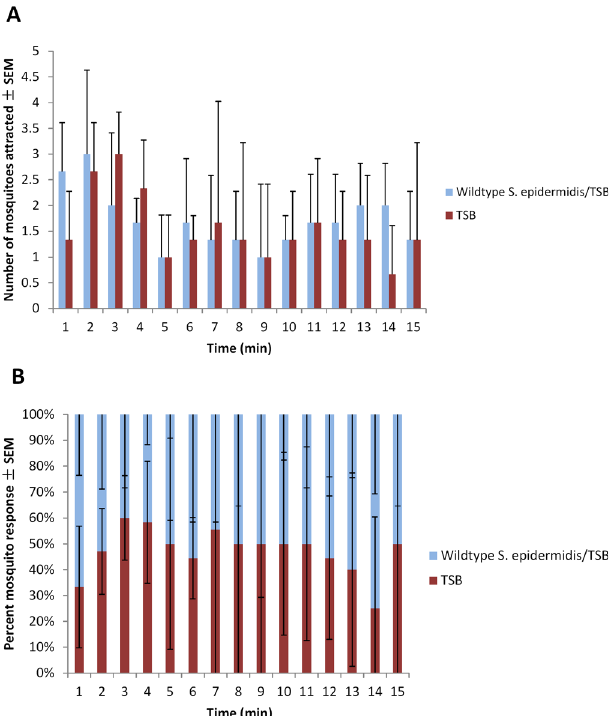
Fig 3. Mean number (A) and (B) percent of 5-8-d-old adult female Ae . aegypti mosquito attracted per minute ± SEM to blood-feeders treated with TSB or wildtype S . epidermidis /TSB located on the right and left sides of the top of a 82 cm x 45 cm x 52 cm Plexiglas cage during 15-min trials (N 1 = 3; n 2 = 50) at approximately 25°C and 80% RH. 1 number of trials conducted; 2 number of mosquitoes used in a